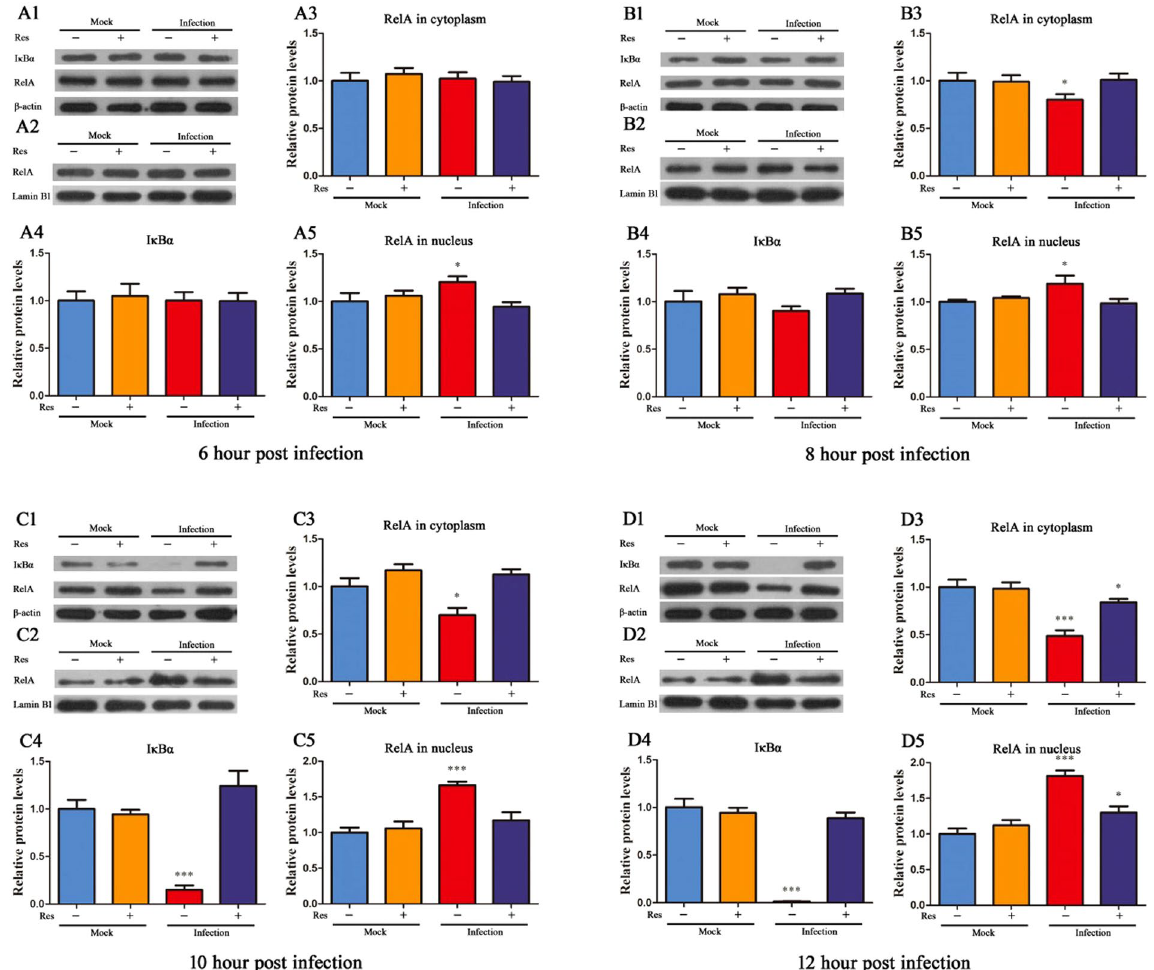
Figure 6. Res inhibited activation of NF- κ B by PRV through inhibiting I κ B α degradation and RelA nuclear translocation. PK-15 cells were infected with or without PRV at an MOI = 1 and with or without Res (65.72 μ M). Expression of NF- κ B signalling pathway proteins, I κ B α , RelA and β -actin in cytoplasmic extracts and RelA and Lamin B1 in nuclear extracts were determined by Western blot at 0, 1, 2, 4, 6, 8, 10 and 12 hpi (there was no significant difference from 0 to 4 hpi in all groups, data not shown). Values are means ± SD (n = 3). Correlation analyses were evaluated by Pearson r2, ns: p > 0.05, * p < 0.05, ** p < 0.01, and *** p < 0.001 vs. normal